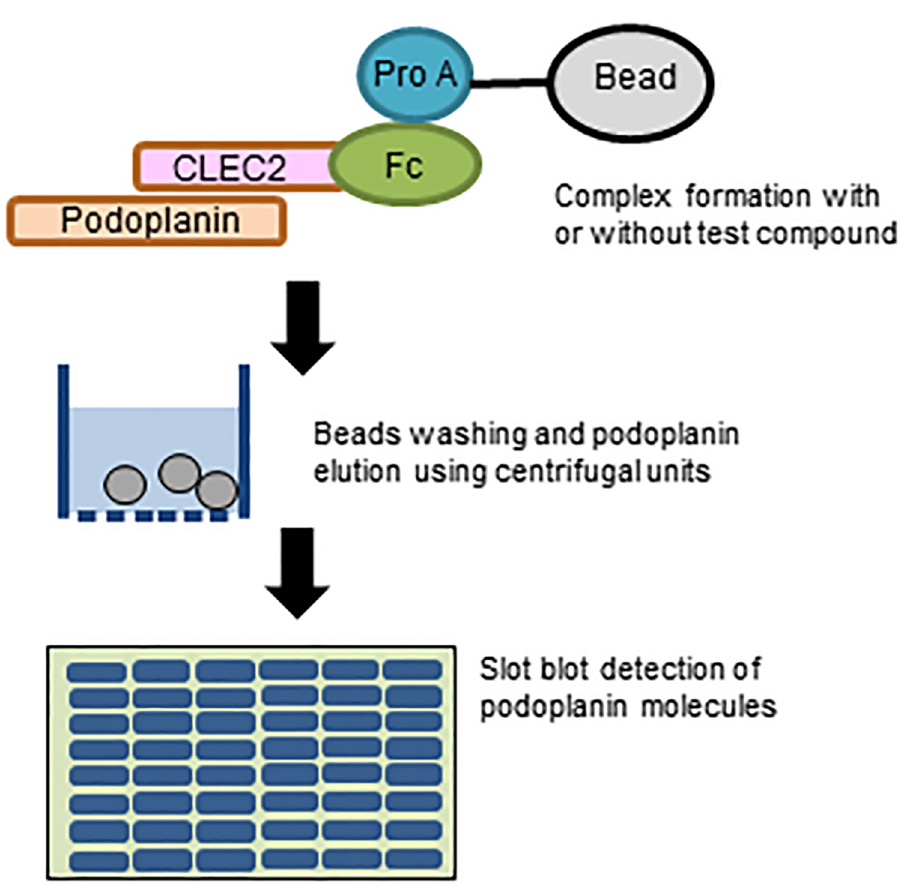
Fig 1. Schematic representation of podoplanin pull-down by Fc-CLEC-2 and protein A beads and subsequent slot blot analysis. Podoplanin and Fc-CLEC-2 were allowed to form complexes in solution with or without a test compound, and the protein complex was then captured by protein A-beads. The tripartite protein beads complexes were then transferred into a 0.5 mL centrifugal filter unit and centrifuged to remove unbound podoplanin and other components through the filter membrane. After four repeated washes by cycles of TBST addition and centrifugation of the tripartite protein beads complexes on the filter unit membrane, podoplanin and Fc-CLEC-2 were dissociated from the protein A-beads by acidification and eluted through the filter. The acid elution fraction was neutralized and then slot blotted onto a PVDF membrane for immunodetection of podoplanin or Fc-CLEC-2. If a test compound is capable of inhibiting the interaction between podoplanin-CLEC-2 through binding to either podoplanin or CLEC-2 moiety or both, slot intensity for podoplanin will be decreased. If a test compound inhibits the interaction between Fc moiety and protein A, slot intensity for Fc-CLEC-2 is expected to